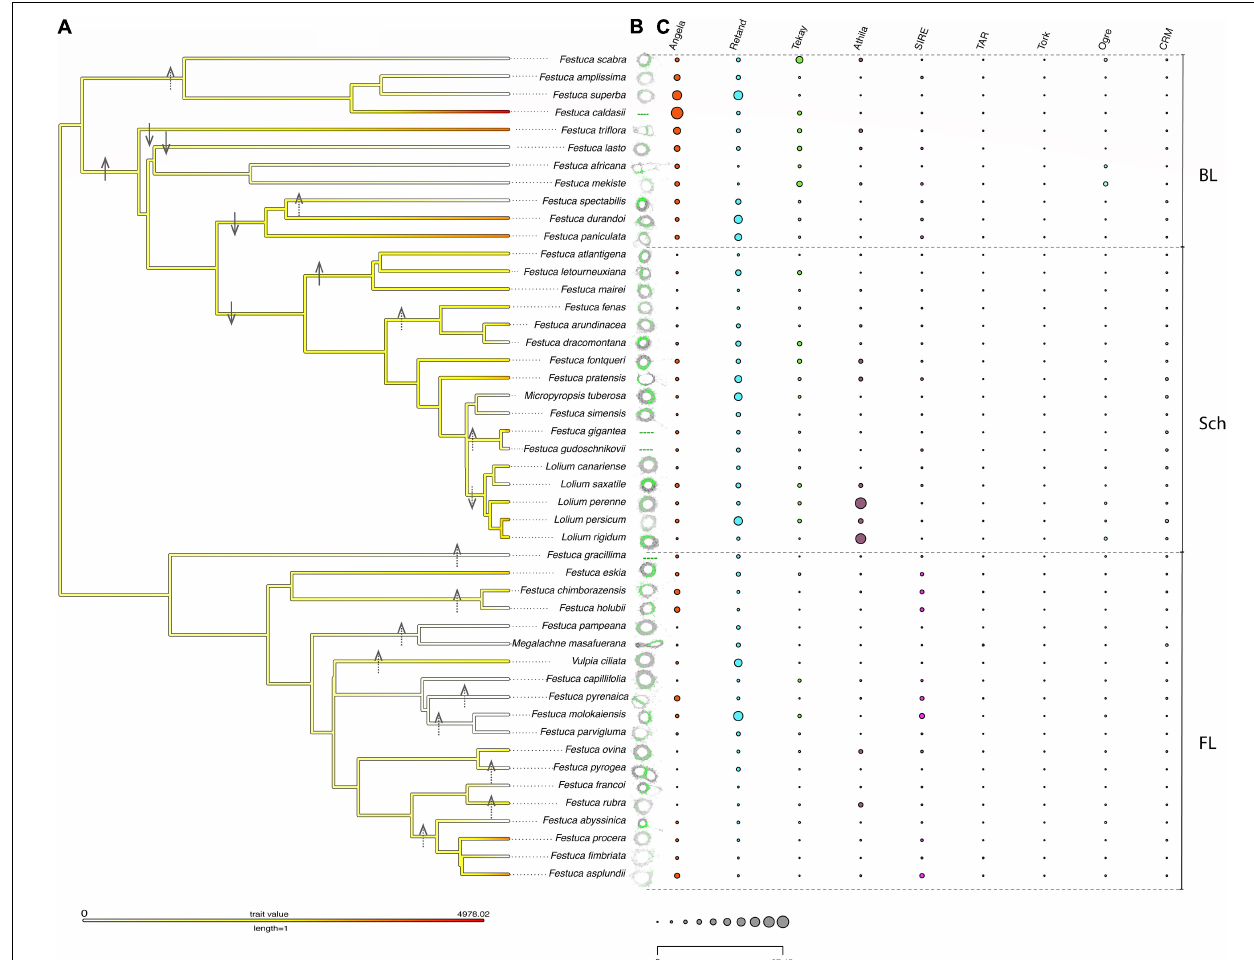
FIGURE 5 | (A) Maximum Likelihood phylogenetic tree (combined plastome + nuclear 35S rDNA data) of the 47 studied Loliinae samples showing their genome sizes by the colors of the terminal branches (color gradients indicate inferred genome size changes); white, missing data. (B) 5S clustering graph plots generated by RE2. (C) Proportions of the most abundant repeat elements (standardized values) obtained from the individual RE2 analysis of repeats are shown for each taxon. Hypothesized scenarios of allopolyploidization and diploidization events mapped onto the tree branches (ancestral allopolyploidization: solid arrow up; ancestral diploidization: solid arrow down; recent allopolyploidization: dashed arrow up; recent diploidization: dashed arrow down). BL, broad-leaved Loliinae; Sch, Schedonorus; FL, fine-leaved